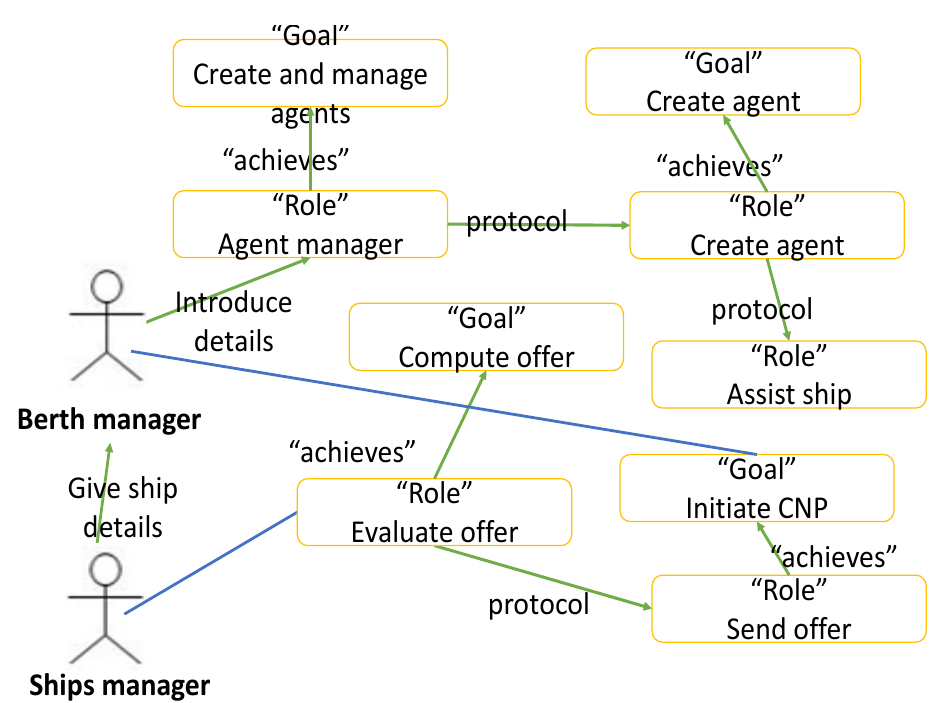
Figure 7. Role model of O-MaSE.